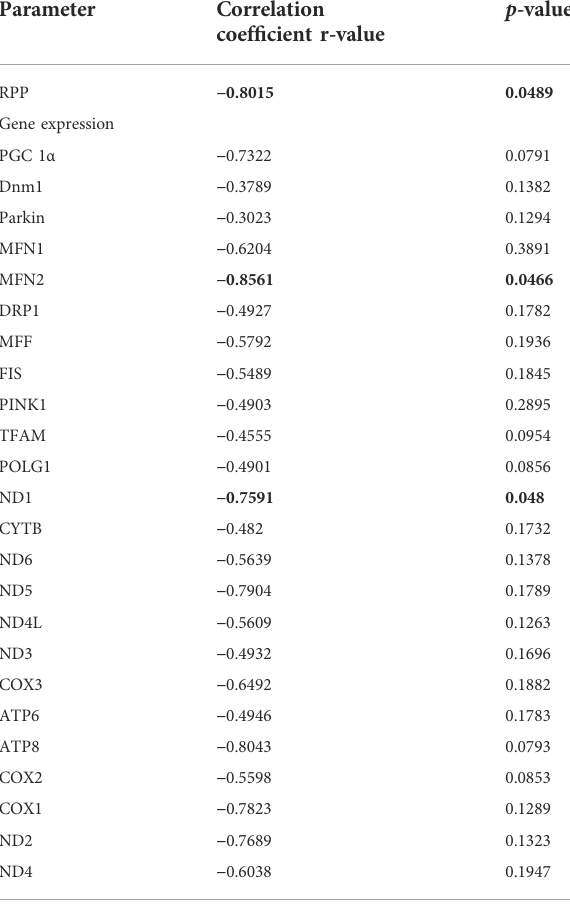
TABLE 2 Correlation data of global DNA methylation with the injury and mitochondrial function during cardiac I/R in adult rats: Pearson correlation of global DNA methylation with the cardiac hemodynamic parameters and listed mitochondrial genes has been calculated and the corresponding p -value and r-value are presented. p < 0.05 was considered statistically signi fi cant.